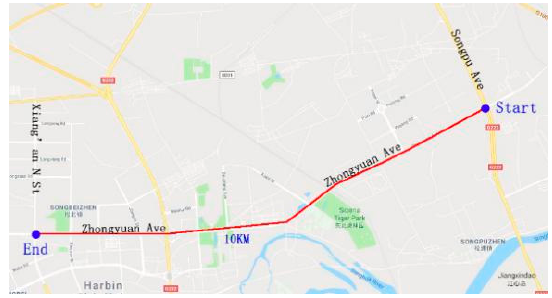
Figure 3. Experimental routes.